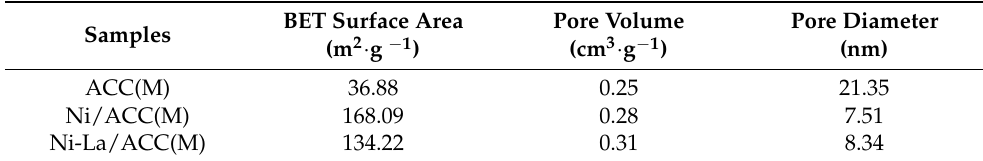
Table 2. Textural parameters of support and catalysts.